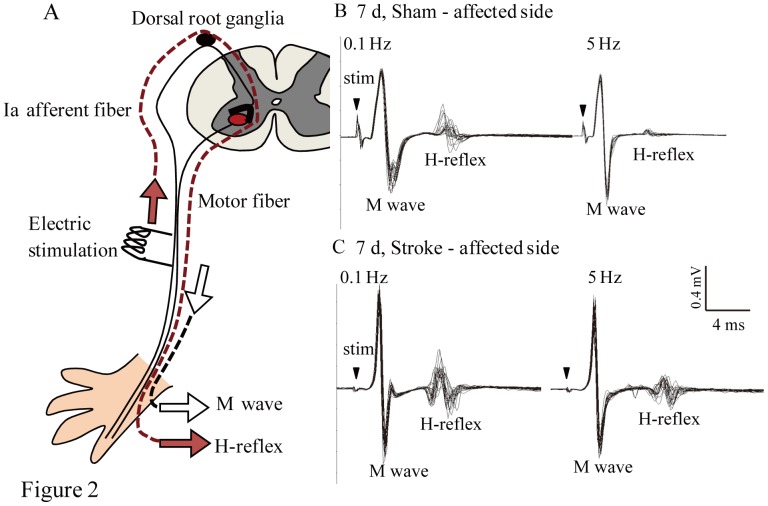
The RDD of the H reflex.A: An illustration of the H reflex in the spinal cord circuit. The M wave is produced by orthodromically transmitting stimulation to motor fibers. The H reflex is a monosynaptic reflex that is transmitted via Ia afferent fibers. B and C: Evoked electromyograms measured in sham mice (B) and on the affected forelimb of stroke mice (C) at 7 d post-stroke. Repeated stimulation at high frequency (5 Hz) decreased the amplitude of the H reflex in sham mice (B). The amplitude of the H reflex on the affected forelimb of stroke mice was not decreased following 5 Hz stimulation (C).